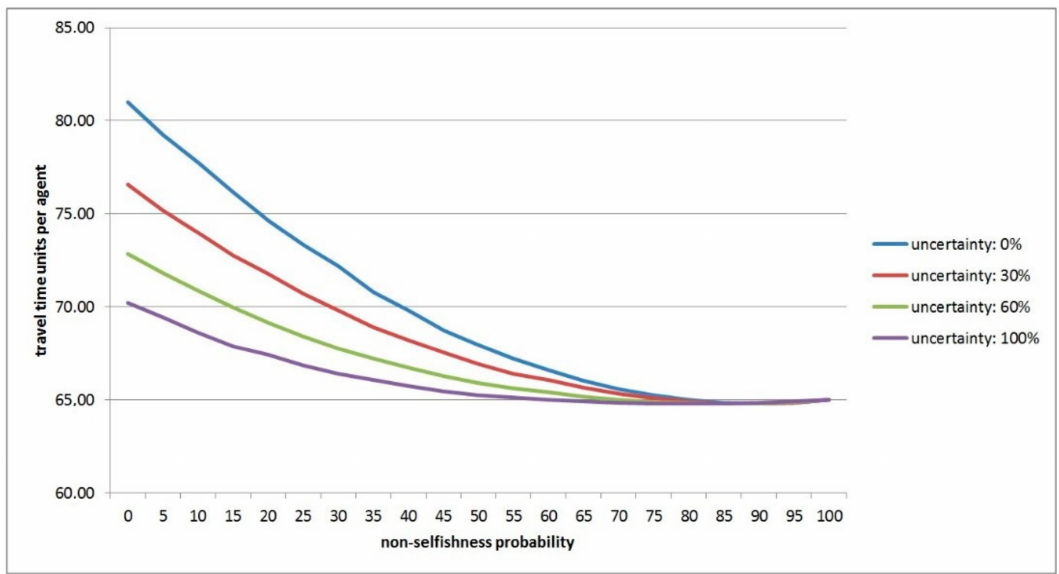
Figure 5. Diagram showing the latency values per agent for given level of travel time uncertainty ∆ t over varying probabilities of non-selfishness P ( NS ) . Table 1. Average latency times C (cid:48) ( f ) of test runs for given values of varying ∆ t and P ( NS )